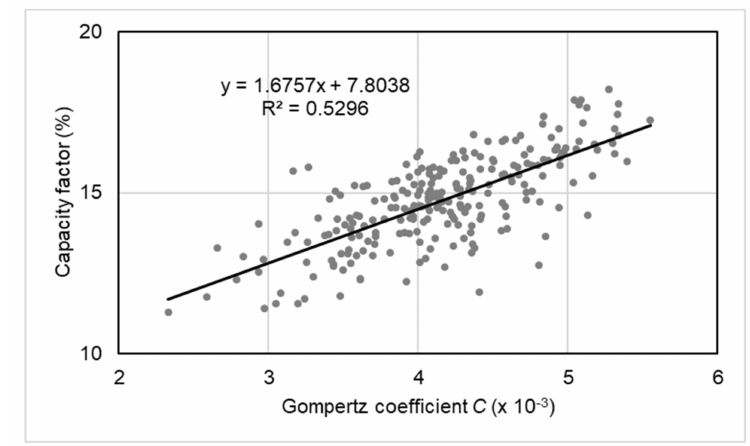
Figure 7. The relationship between the Gompertz coe ffi cient C and the capacity factor (mean capacity factor = 14.8 ±